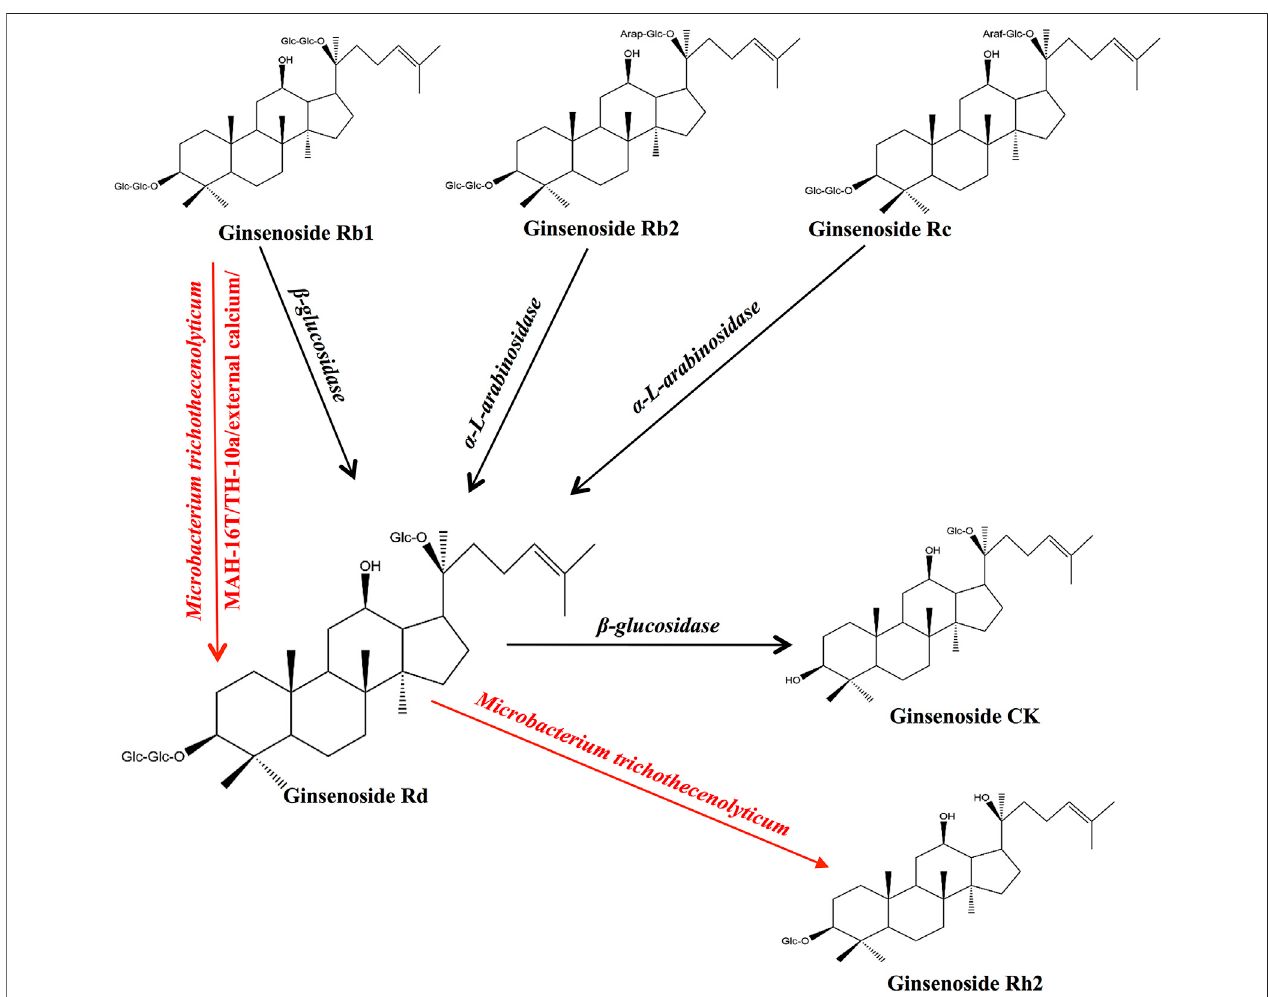
FIGURE 1 | Biotransformation and pharmacokinetics of ginsenoside Rd in vivo .